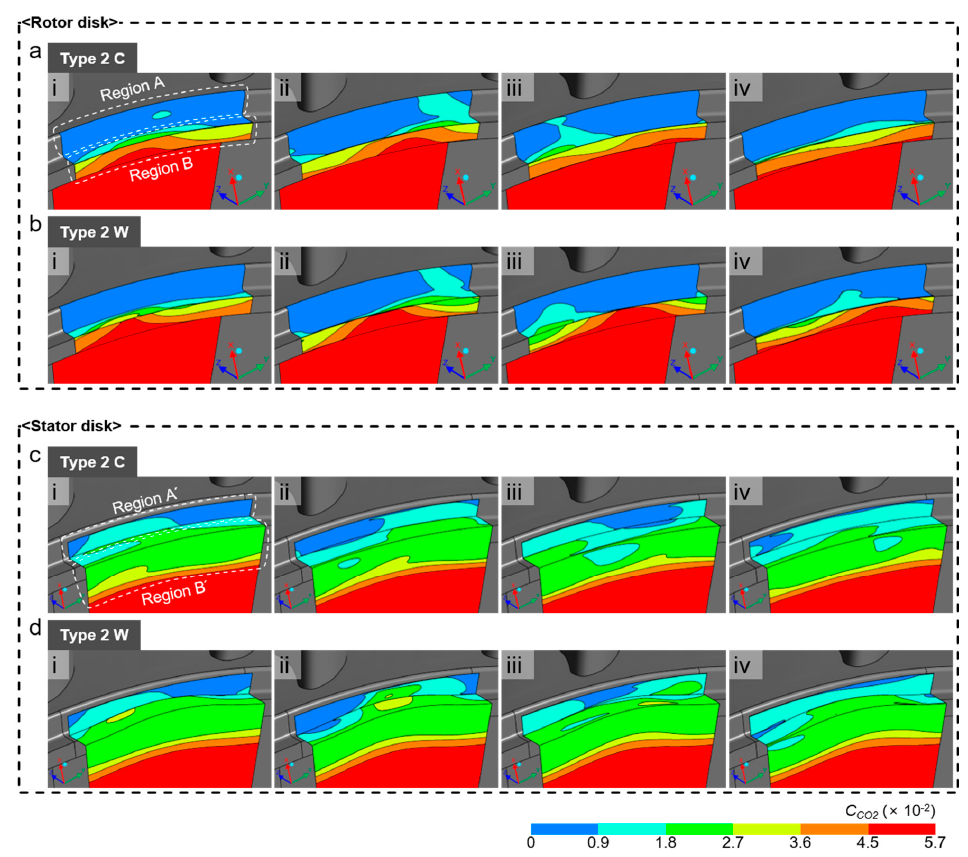
Figure 11. Contour of C CO2 on the surface of the rotor disk of ( a ) Type 2 C and ( b ) Type 2 W, and the stator disk of ( c ) Type 2 C and ( d ) Type 2 W.